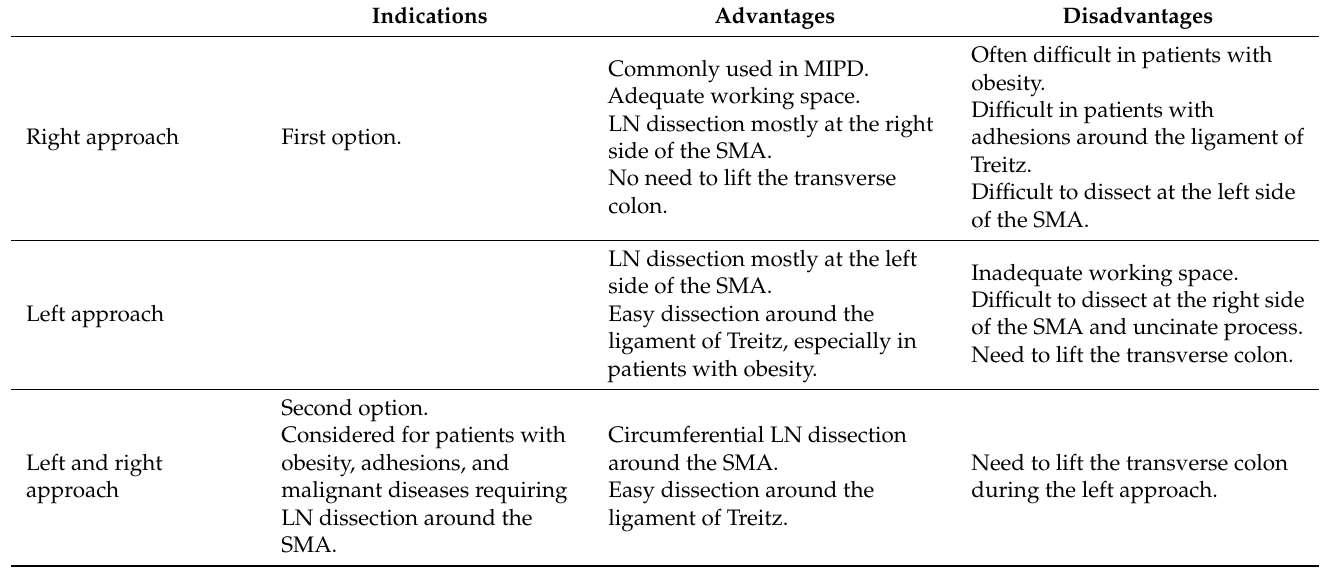
Table 1. Our protocol to approaching the superior mesenteric artery in robotic pancreatoduodenectomy.